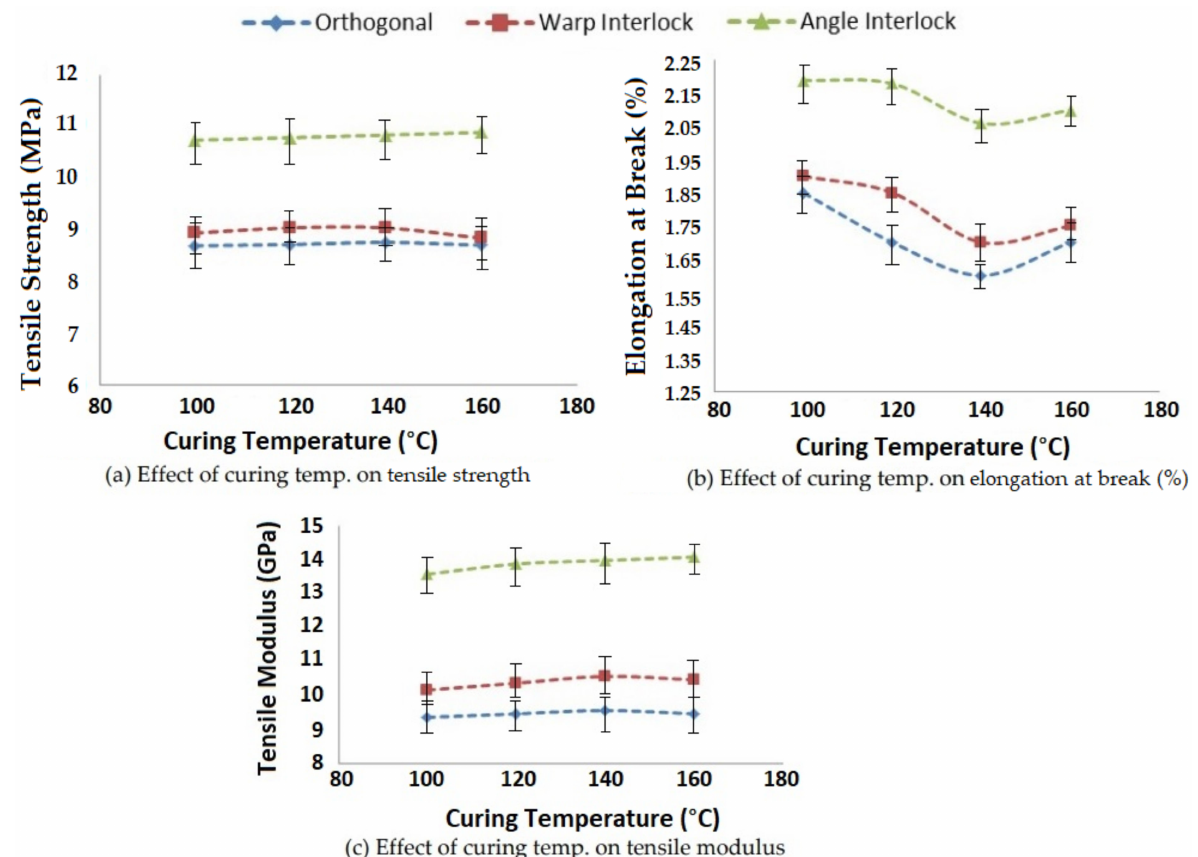
Figure 7. Effect of curing temperature on the tensile properties of 3D woven